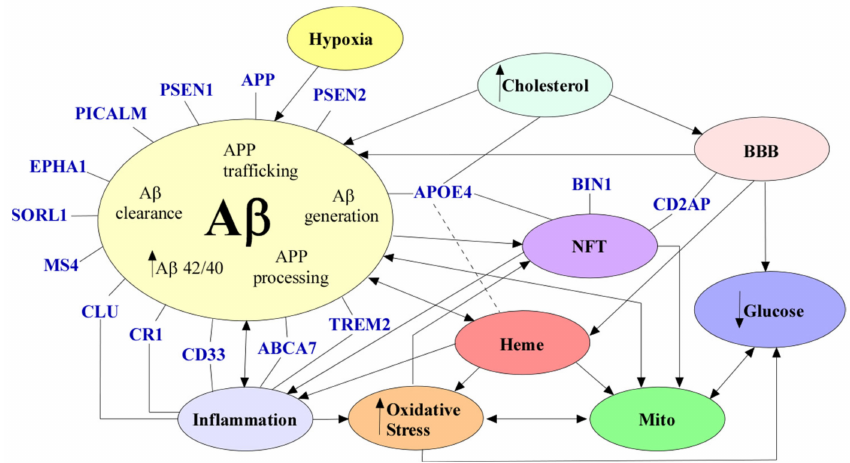
Figure 5. The mechanisms of AD. A β (in beige) can cause inflammation (in blue), NFTs (in purple), dysregulated heme metabolism (in red), and mitochondrial dysfunction (in green). Increased choles- terol (in light blue) levels have been seen to cause BBB (in pink) disruption and A β accumulation. A dysfunctional BBB can cause decreased A β clearance, increased heme, and decreased glucose (in dark blue). NFTs have been seen to cause mitochondrial dysfunction and inflammation (in blue). Oxidative stress (in orange) can cause mitochondrial dysfunction, decreased glucose, and NFTs. Glucose hypometabolism can cause decreased ATP. Inflammation can cause decreased amyloid beta clearance and oxidative stress. Mitochondrial dysfunction can cause oxidative stress, A β generation and glucose hypometabolism. Hypoxia (in yellow) can cause A β generation. Dysregulated heme homeostasis can cause oxidative stress, mitochondrial dysfunction, and dimerization of APP. All ge- netic risk factors are denoted in blue. Variants in PICALM, PSEN1, APP, PSEN2, EPHA1, SORL1, MS4, TREM2, CLU, CR1, CD33, ABCA7 , and APOE4 can all indirectly or directly cause A β accumulation. CLU, CR1, CD33, ABCA7 , and TREM2 have a role in inflammation. APOE, BIN1 and CD2AP variants can cause NFTs. Abbreviations: amyloid beta (A β ), neurofibrillary tangles (NFT), blood–brain barrier (BBB), mitochondrial dysfunction